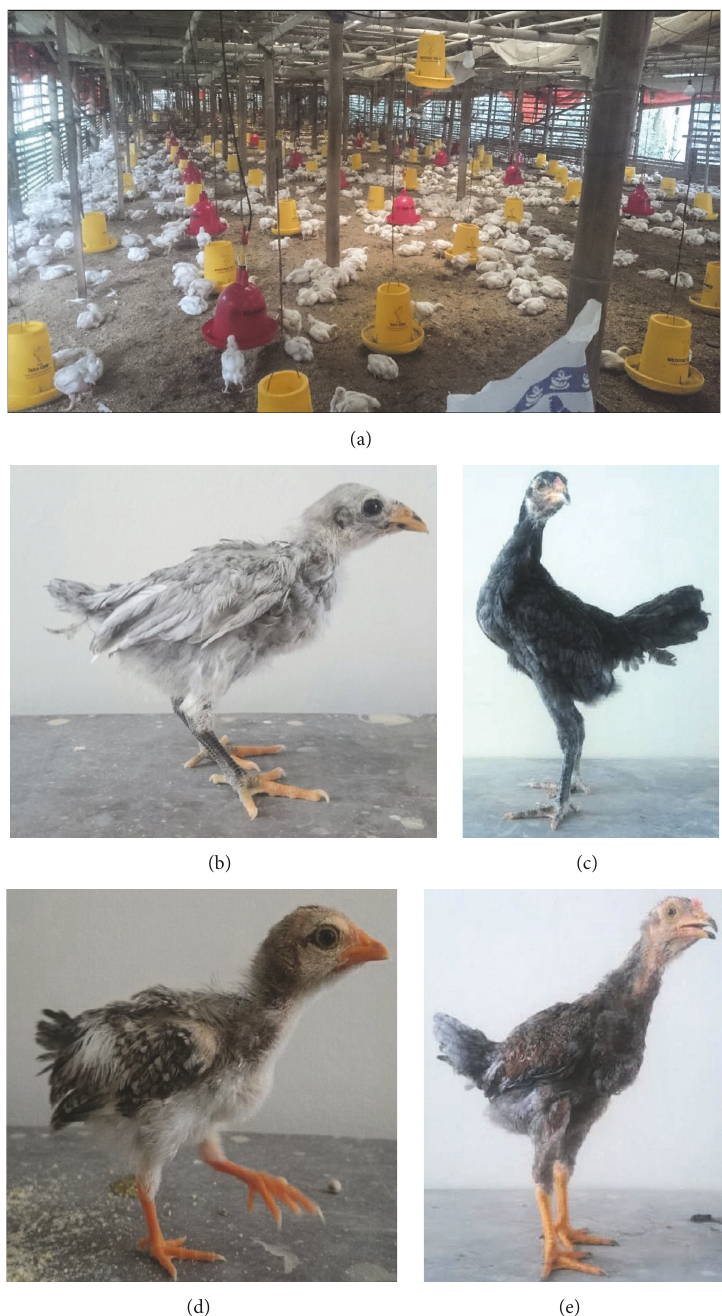
Figure 1: Conditions of flocks with coccidiosis in a semi-intensive farming system in Central Java. (a) Semi-intensive farming of broilers (19 days old), with almost all chicken positive for E. tenella infection, showing unspecific clinical signs. Sentul breed in (b) 5-day-old and (c) 21-day-old cases. Jawa breed in (d) 5-day-old and (e) 21-day-old